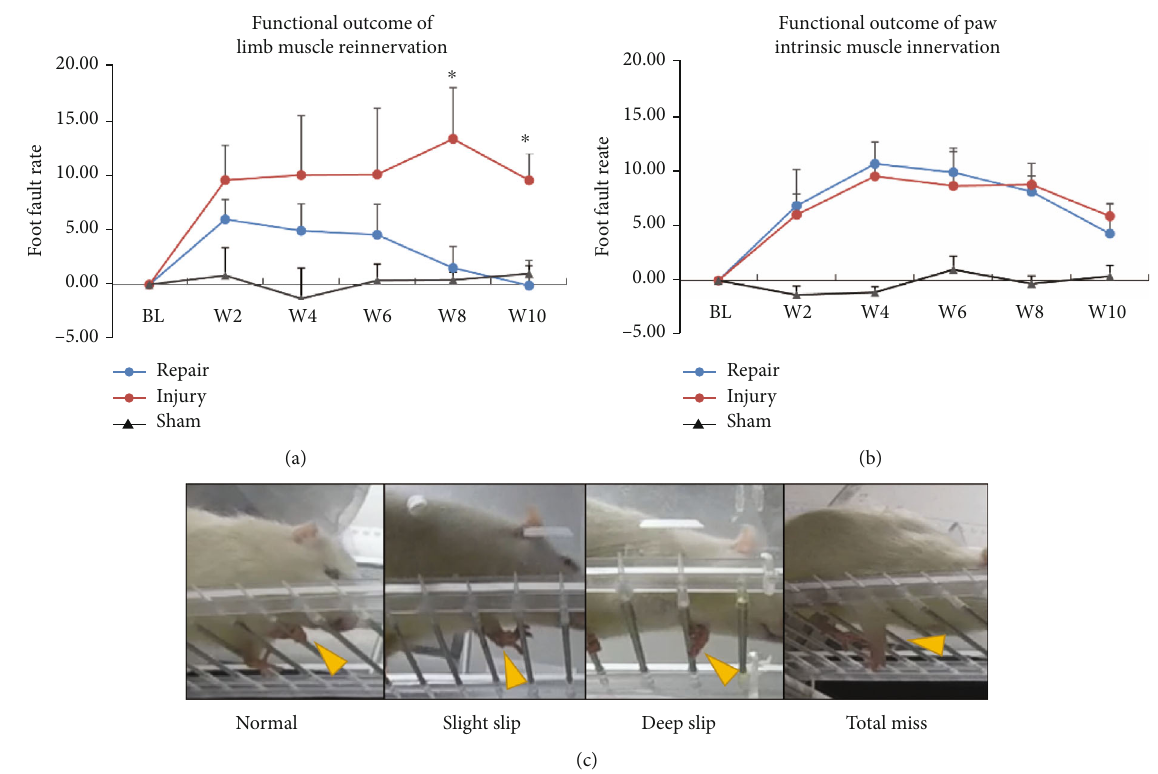
Figure 2: The functional outcome of the skilled limb movement after peripheral nerve injury. (a) In the limb muscle reinnervation design, the foot fault rate of the nerve repair group was observed to be indi ff erent from the sham group at W8 and W10, but signi fi cantly lower than that of the injury group. (b) In the intrinsic muscle reinnervation design, we found no recovery of the skilled foot function in the repair group compared to the injury group, resulting in a signi fi cantly higher foot fault rate than the sham group. (c) Exemplary patterns of various degrees of foot fault (yellow arrow) in rat forelimb during skill walking. ∗ p < 0 : 050 . ns: nonsigni fi